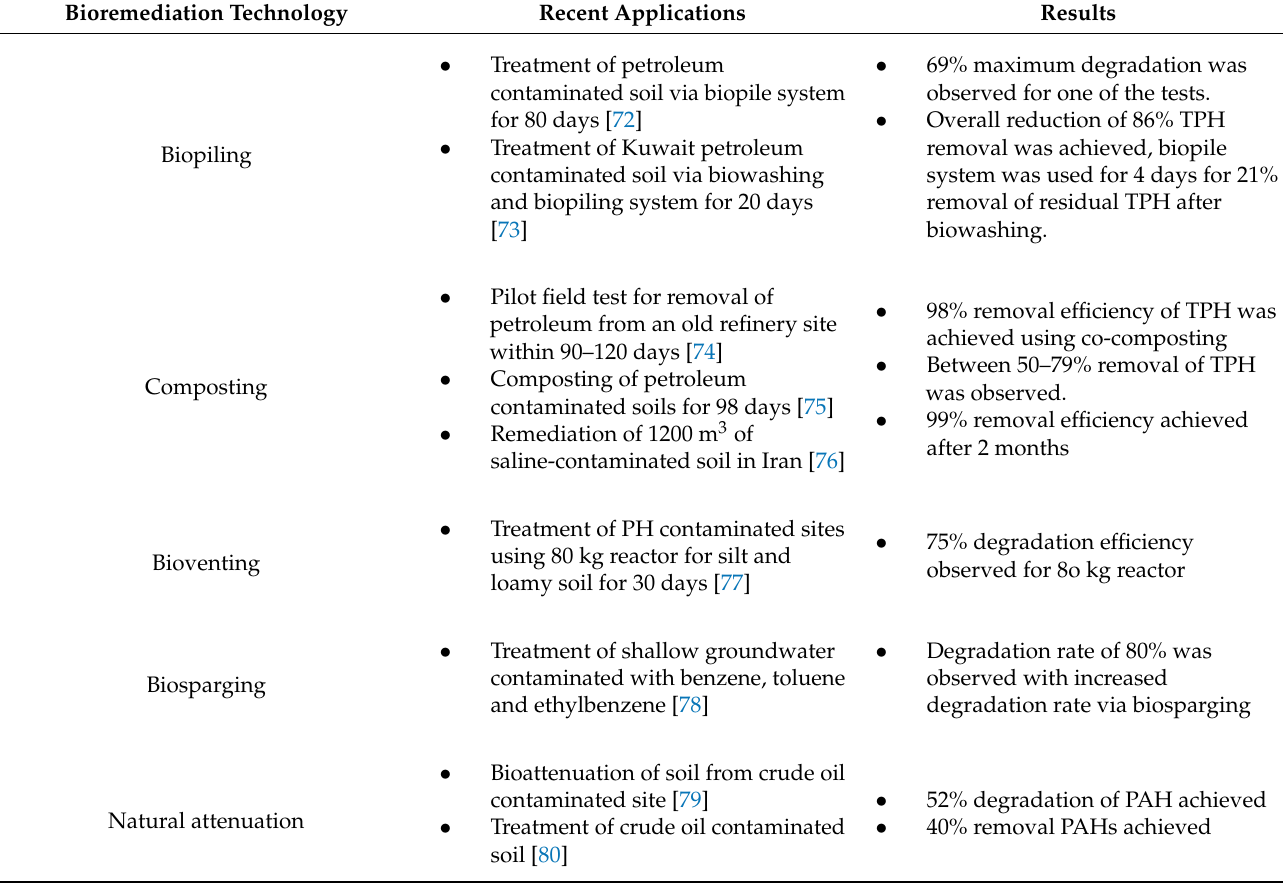
Table 4. Recent application of some of the bioremediation techniques and the results